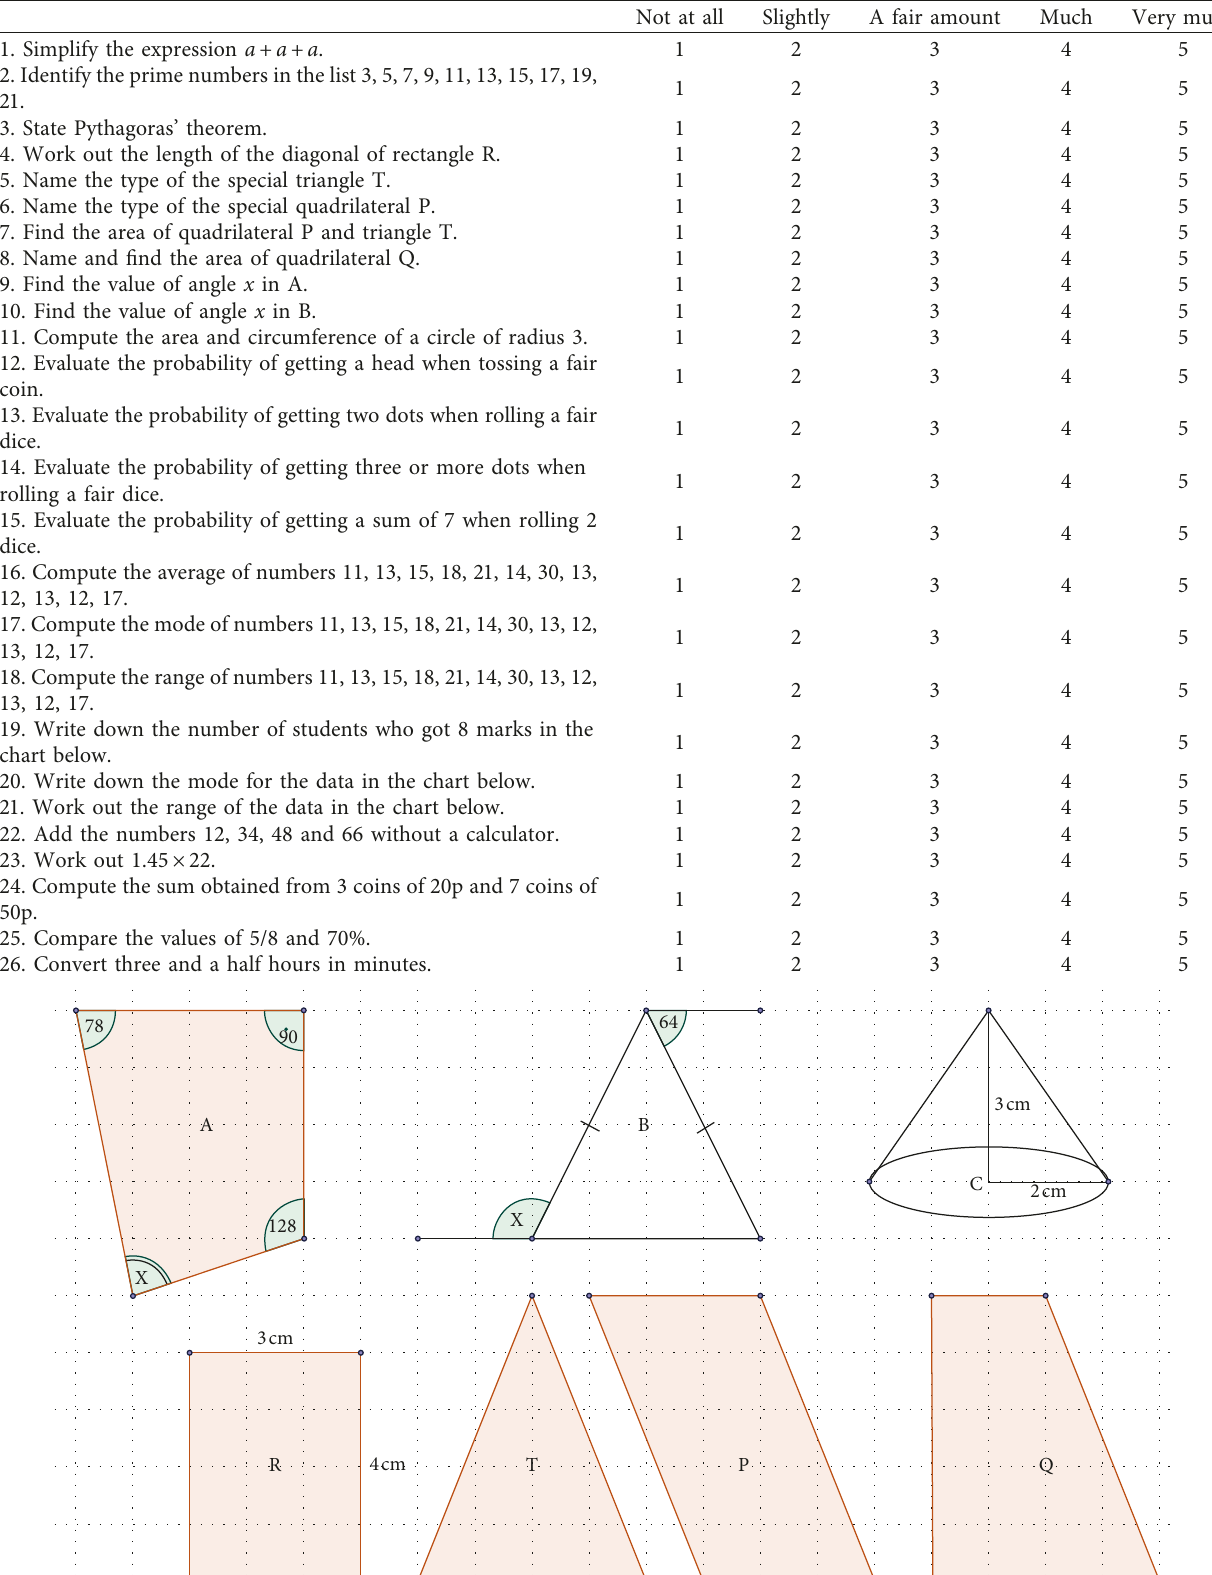
Table 1: Questionnaire: Using the scale below (circling the relevant number), how anxious would you feel being asked to . ... .. Not at all Slightly A fair amount Much Very